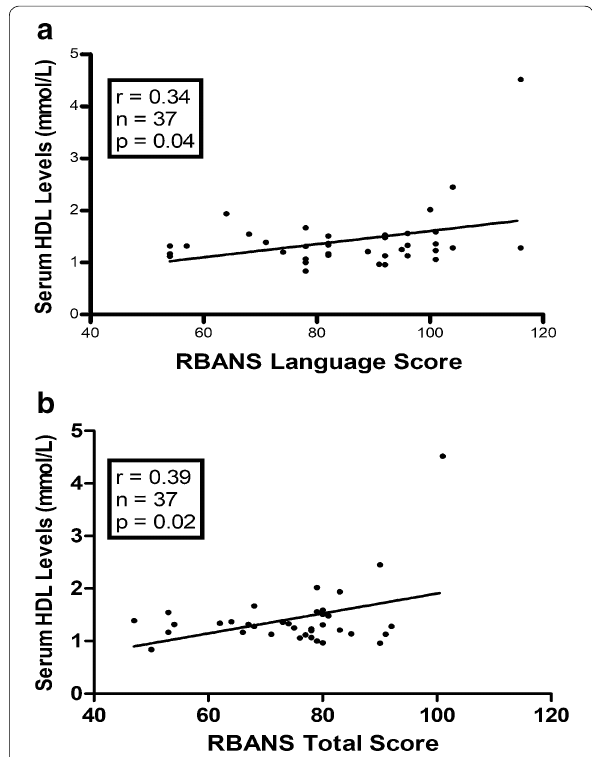
Fig. 2 For patients with BD, a serum HDL levels were positively associated with the language score (r the positively correlation of serum HDL levels with the RBANS total score (r 0.39, P = =